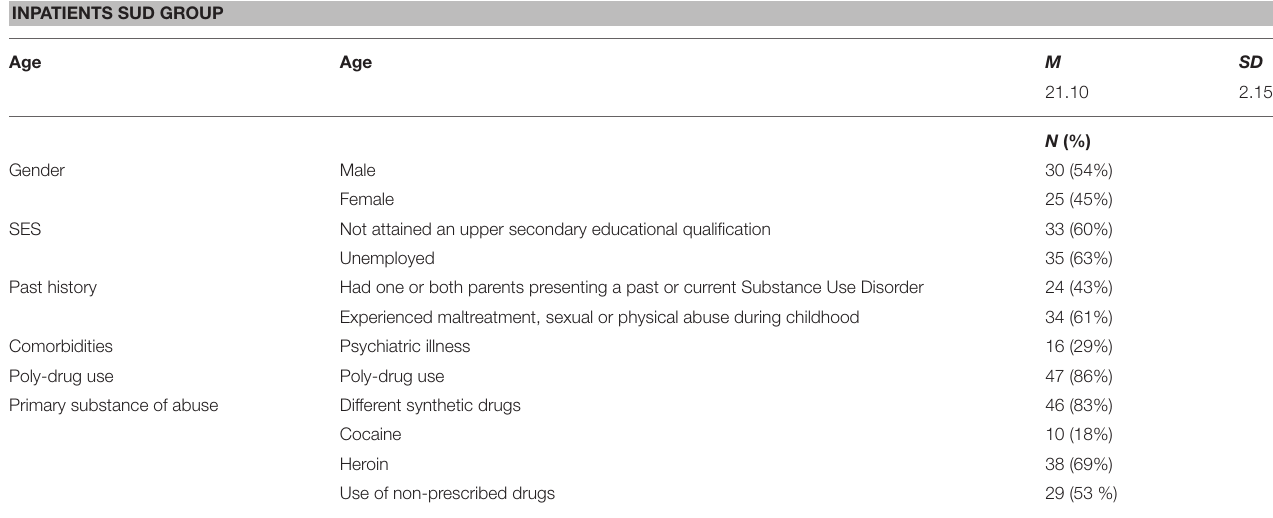
TABLE 2 | Descriptive characteristics of SUD